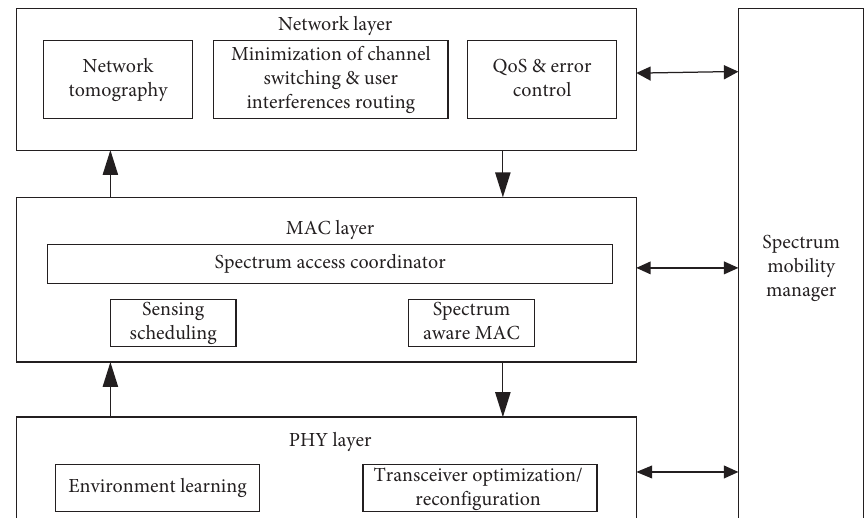
Figure 1: Communication model for the proposed routing